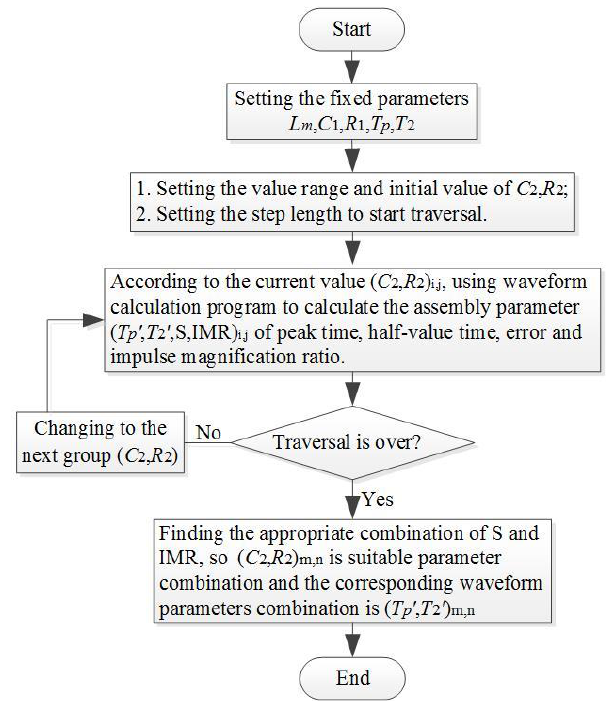
Figure 5. Program flowchart to calculate the circuit parameters.